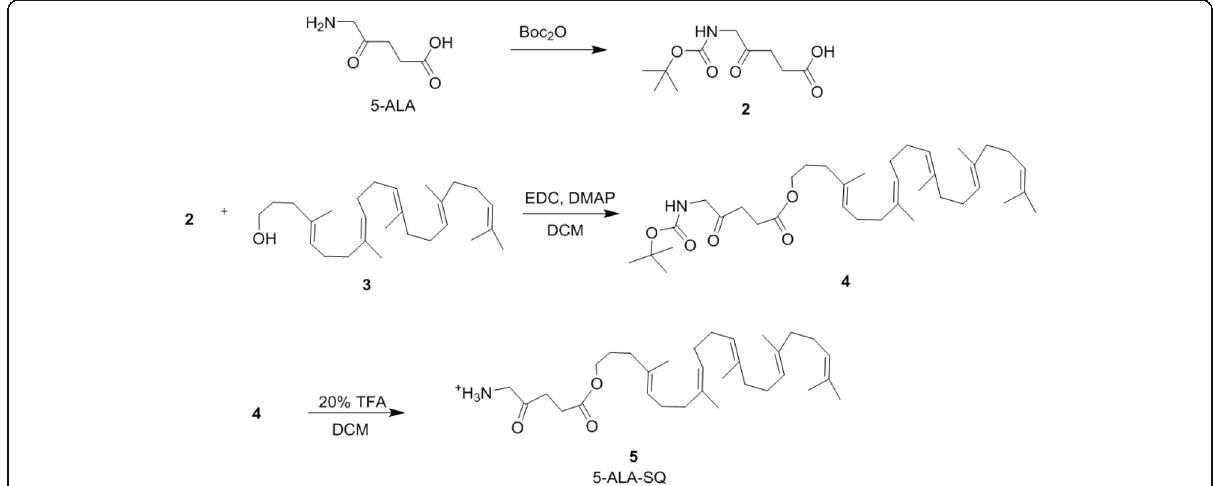
Fig. 2 5-ALA-SQ building block synthesis. 5-ALA-SQ was synthesized in four synthetic steps using convergent synthesis from 5-ALA and